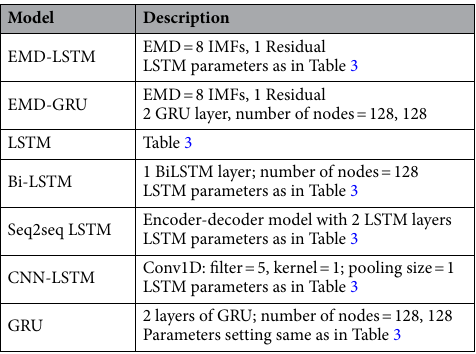
Table 4. Description of comparative models.